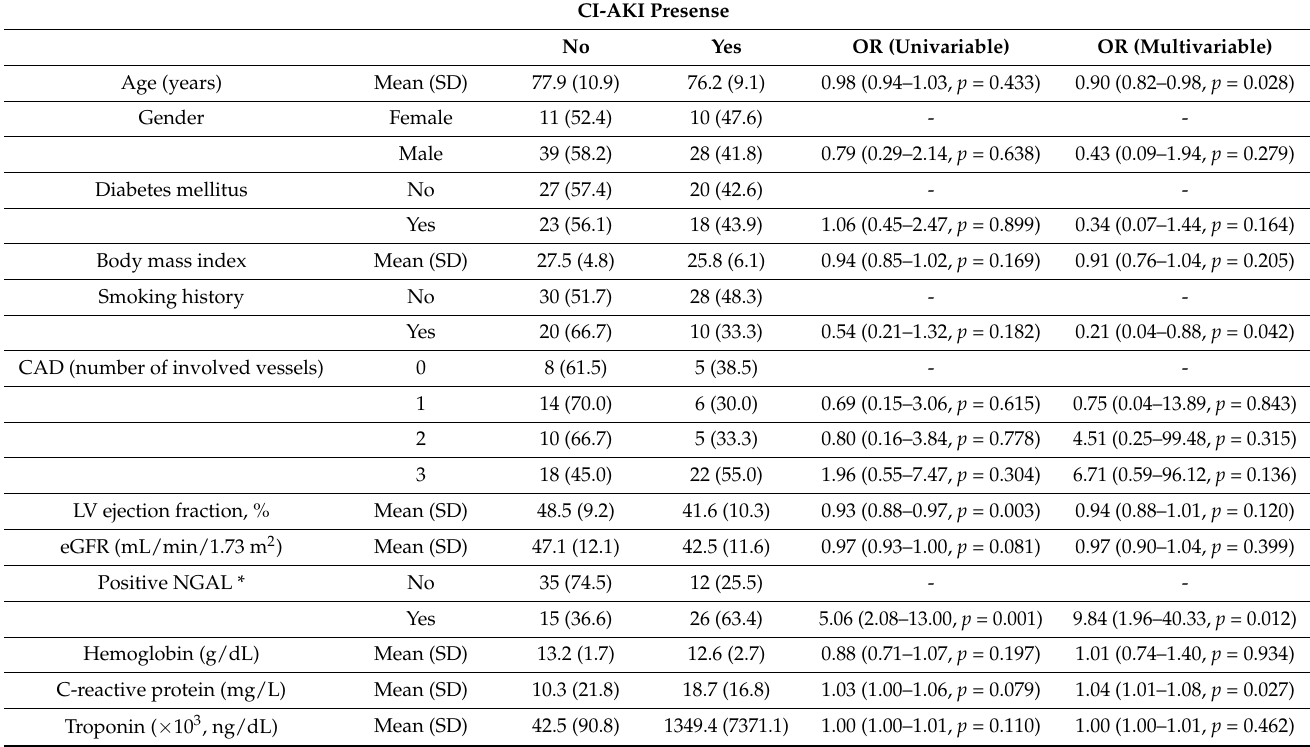
Table 2. In a multivariate logistic regression model, serum NGAL levels >127 ng/mL were independently associated with CI-AKI (HR 9.84, 95% CI: 1.96–40.3; p = 0.01). Other factors associated with CI-AKI included age, smoking history, and CRP. Table 2. Univariate and multivariate logistic regression models for the prediction of acute kidney injury. CI-AKI